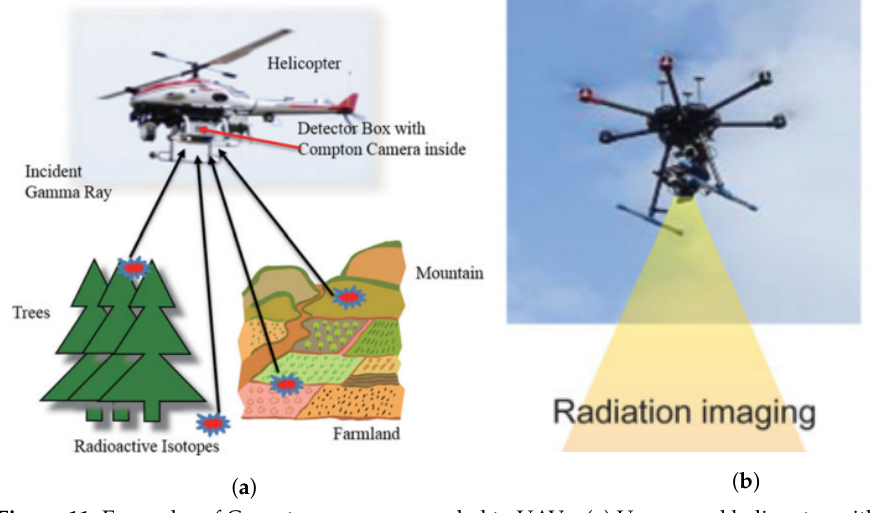
Figure 11. Examples of Compton cameras coupled to UAVs: ( a ) Unmanned helicopter with Compton camera composed by two arrays of Ce-doped Gd-Al-Ga-garnet (Ce:GAGG) scintillation crystals [178], reprinted by permission of the publisher (Taylor & Francis Ltd, http://www.tandfonline.com). ( b ) Multi-rotor UAV with two stages of Ce:GAGG crystals mounted in a gimbal. Reproduced, with permission, from Reference [186]; published by Taylor & Francis, 2018, under the terms of the https://creativecommons.org/licenses/by-nc-nd/4.0/CC BY-NC-ND 4.0